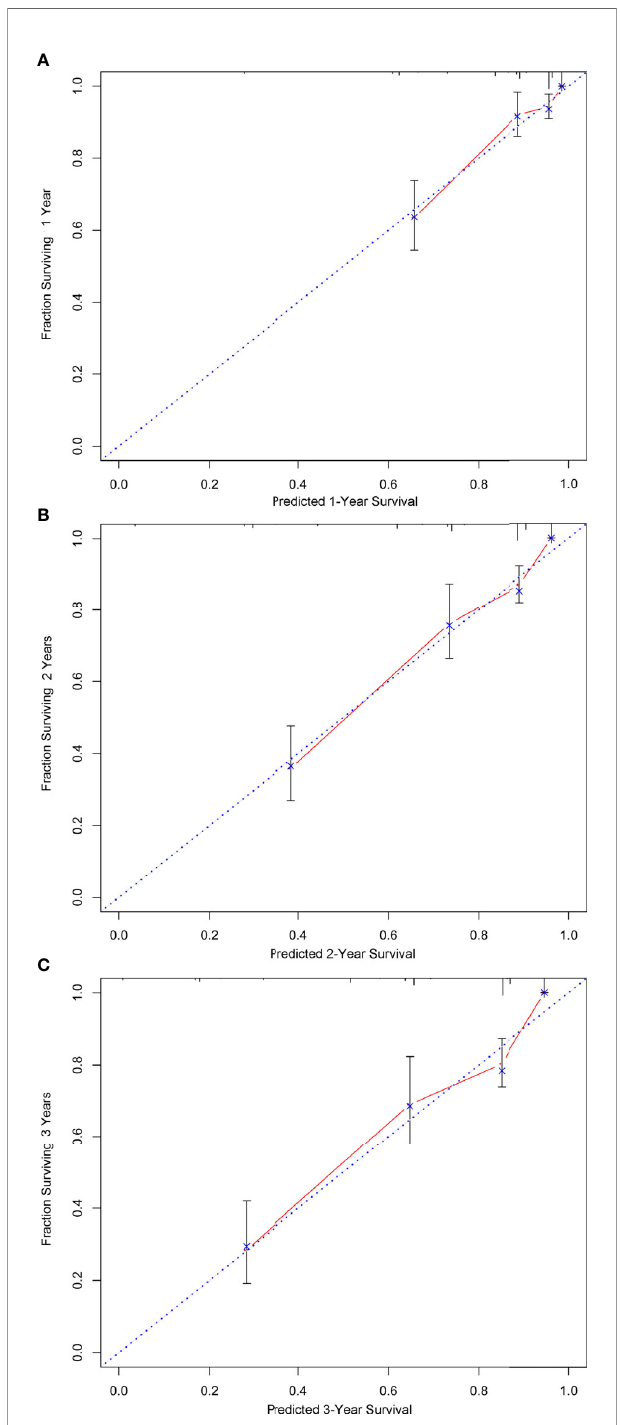
FIGURE 6 | The calibration of the nomograms for predicting 1-, 2-, and 3- year survival probabilities. (A – C) show the nomograms of 1-, 2-, and 3-year survival probabilities, respectively. Plots show that the predicted survival rates closely corresponded with the actual survival rates, which are represented by the dotted